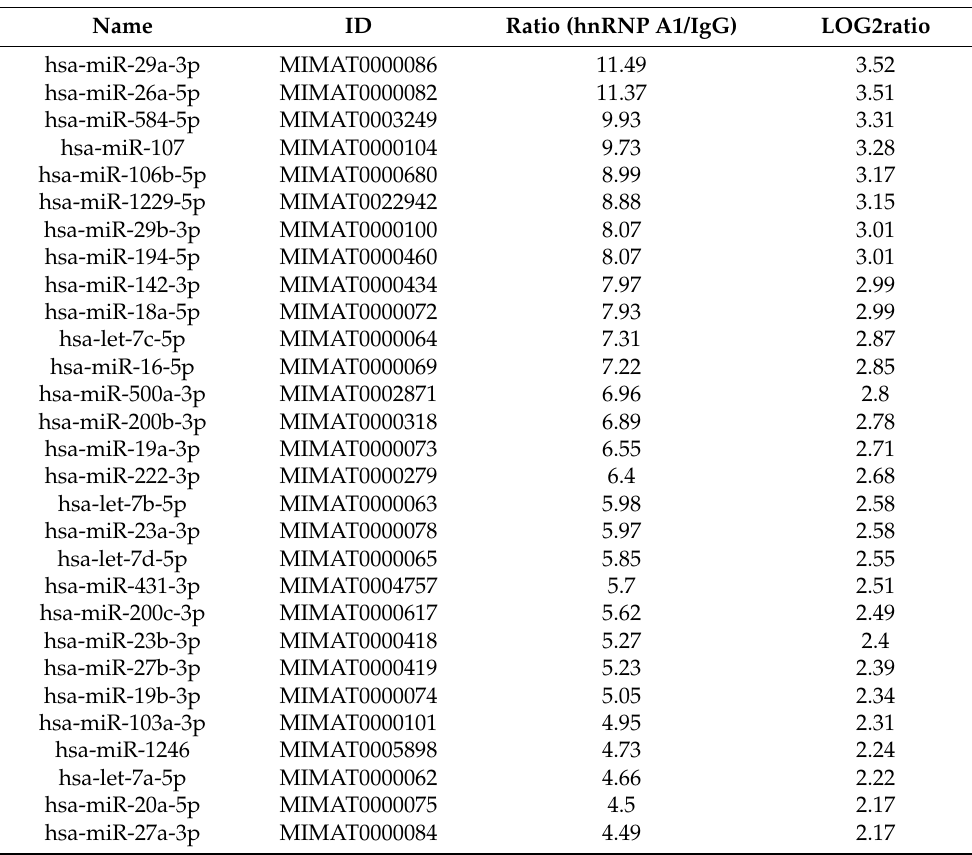
Figure 3. Methodology for the identification of RNA-binding protein (RBP)-binding micro RNAs (miRNAs) and messenger RNAs (mRNAs). RNA-IP with microarray analysis is a powerful strategy to exhaustively identify unknown PBP-miRNA or messenger RNA (mRNA) interactions. miRNAs and mRNAs, which interact with a specific RNA-binding protein (RBP) in cancer cells, are subjected to pulldown assays by immunoprecipitation using anti-RBP antibodies extracted through the phenol–chloroform extraction method and identified via microarray analysis. hnRNP A1 interacting miRNAs identified by RNA-IP in combination with microarray analysis. miRs with Greater than 4-Fold Expression Compared to the Isotype Control